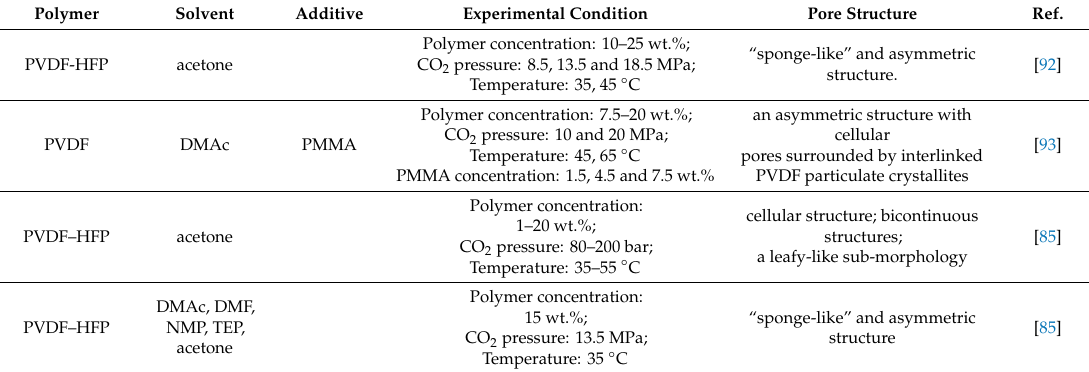
Table 3. Examples of supercritical carbon dioxide (sc-CO 2 ) use as a non-solvent in the preparation of PVDF